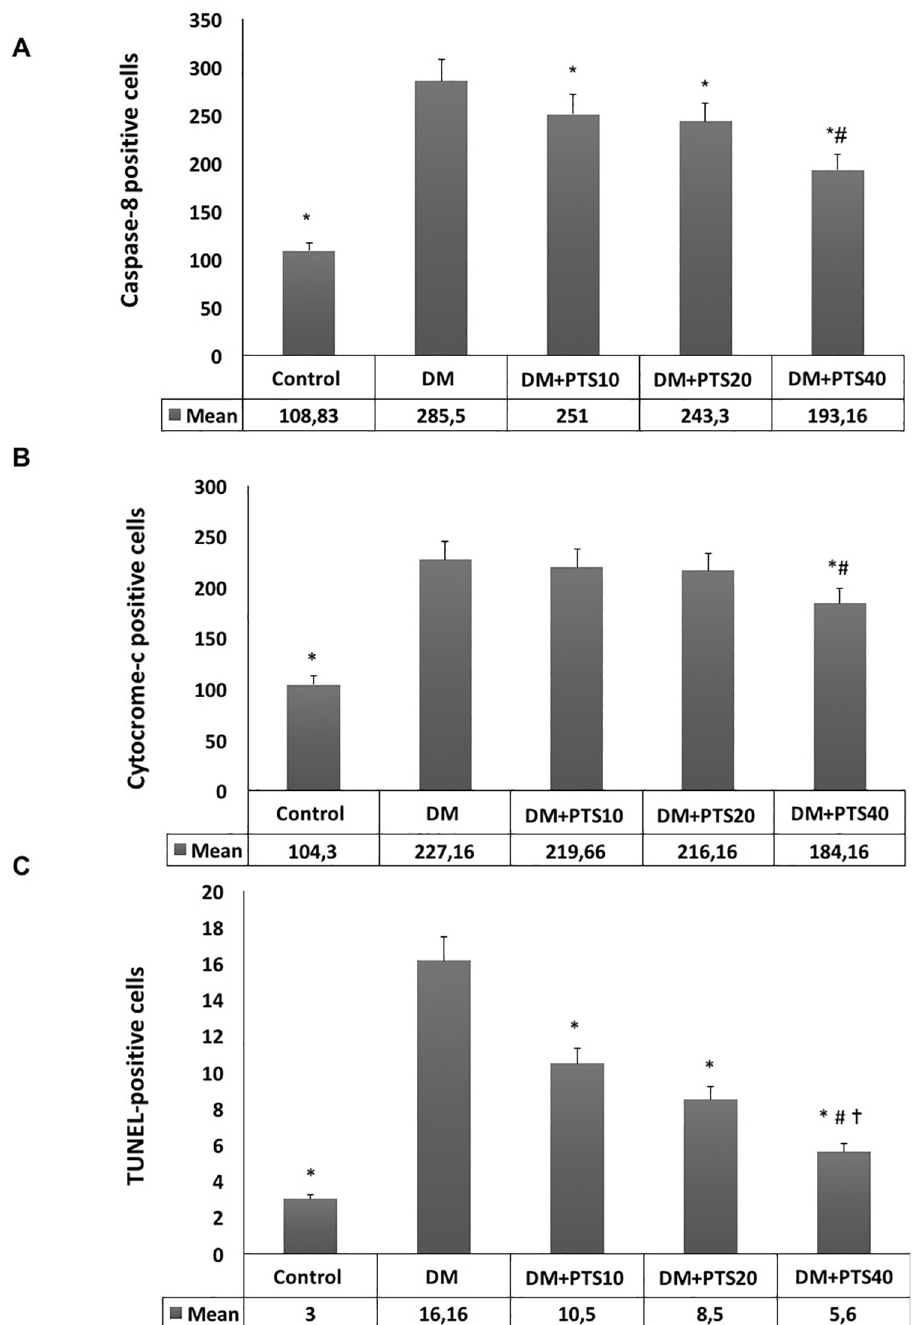
Fig 1. The cells counted staining using Caspase-8, Cytocrome-c, and TUNEL method in the rat groups after STZ- application to end of the experimental period. (A). For Caspase-8; � significantly different from DM (P < 0.001 for all), # different from DM+PTS10, DM+PTS20 (P < 0.001 for all). (B) For Cytocrome-c; � Significantly different from DM (P < 0.001 for all), # different from DM+PTS10, DM+PTS20 (P < 0.001 for all). (C) For Tunnel-method; � Significantly different from DM (P < 0.05 for all), # different from DM+PTS10 (P = 0.033), and ✝ similar to Control.